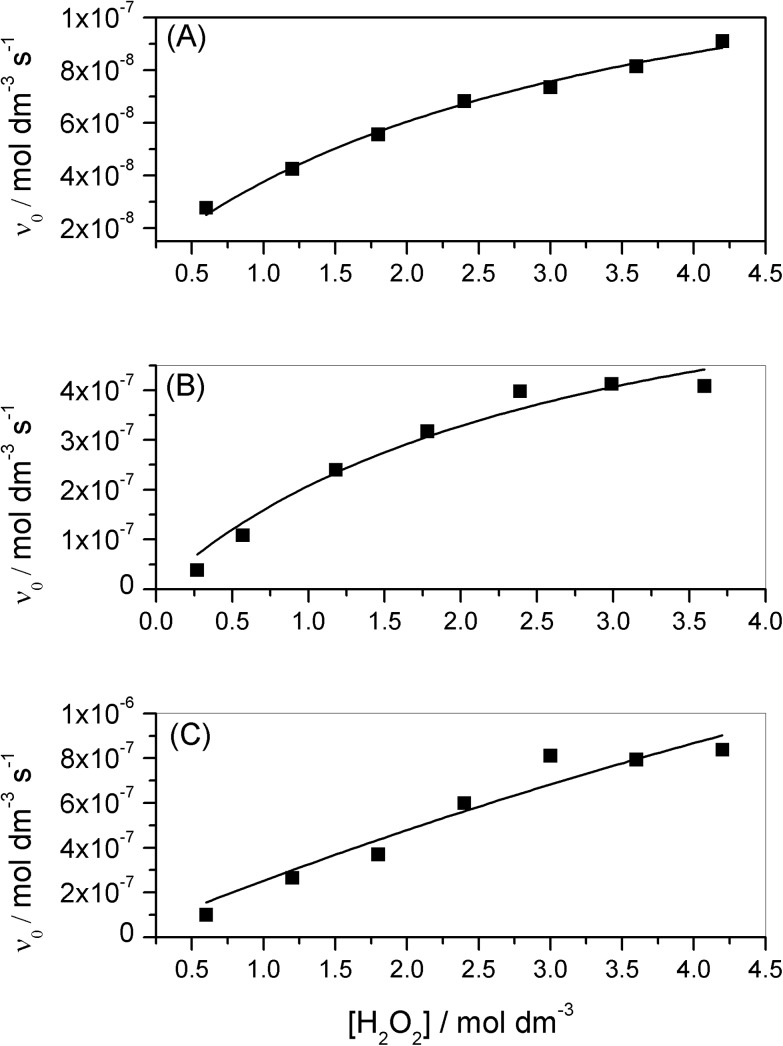
Initial rate (v
0) of O2 evolution as a function of initial H2O2 concentration.Experimental data (square); Nonlinear Least Square fitting using Michaelis-Menten equation (continuous line). (A) [Co(L)(H2O)](ClO4)2; (B) [Ni(HL)](ClO4)2; (C) [Cu(HL)](ClO4)2. [complex] = 3.0×10−3 mol dm-3.